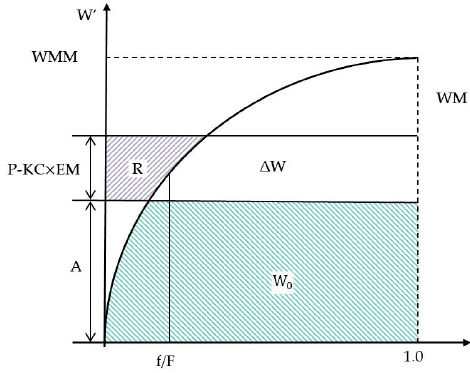
Figure 3. The tension water capacity curve in Xinanjiang Model.